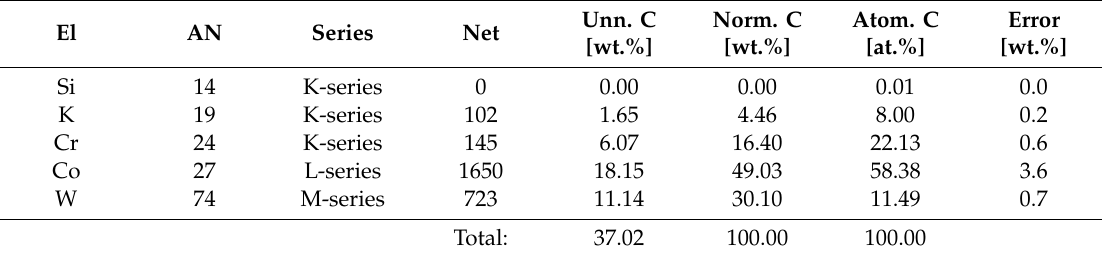
Figure 7. The energy dispersive X-ray spectrometer (EDS) face sampling area (used electrode). Table 4. The elemental contents of the EDS face sampling area (used electrode). El–element; AN–atomic number; Series–characteristic X-ray lines; unn. C [wt.%]–the unnormalized concentration in weight percent of the element; norm. C [wt.%]–the normalized concentration in weight percent of the element; Atom. C [at.%]–the atomic weight percent.